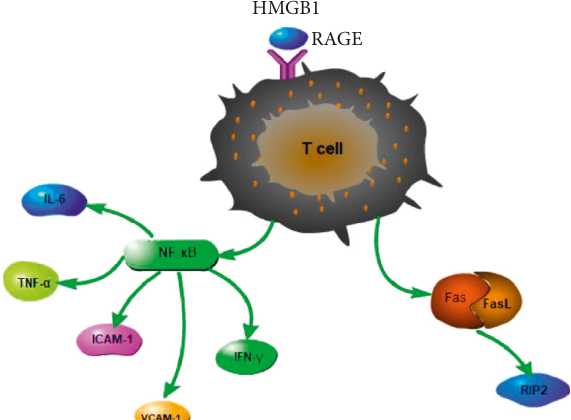
Figure 2: HMGB1 signals by binding to RAGE to activate T-cell cytokine release and Fas/FasL signal pathway in uveitis. In uveoretinitis, HMGB1 binds RAGE and activates NF- κ B, pro- moting the release of TNF- α , IL-6, ICAM-1, and VCAM-1. HMGB1 also can activate Fas/FasL-mediated signaling. In Behcet’s disease, expression of proinflammatory cytokines such as TNF- α , IL-6, and IFN- c in neutrophils is enhanced by extracellular HMGB1, which acts via the NF- κ B